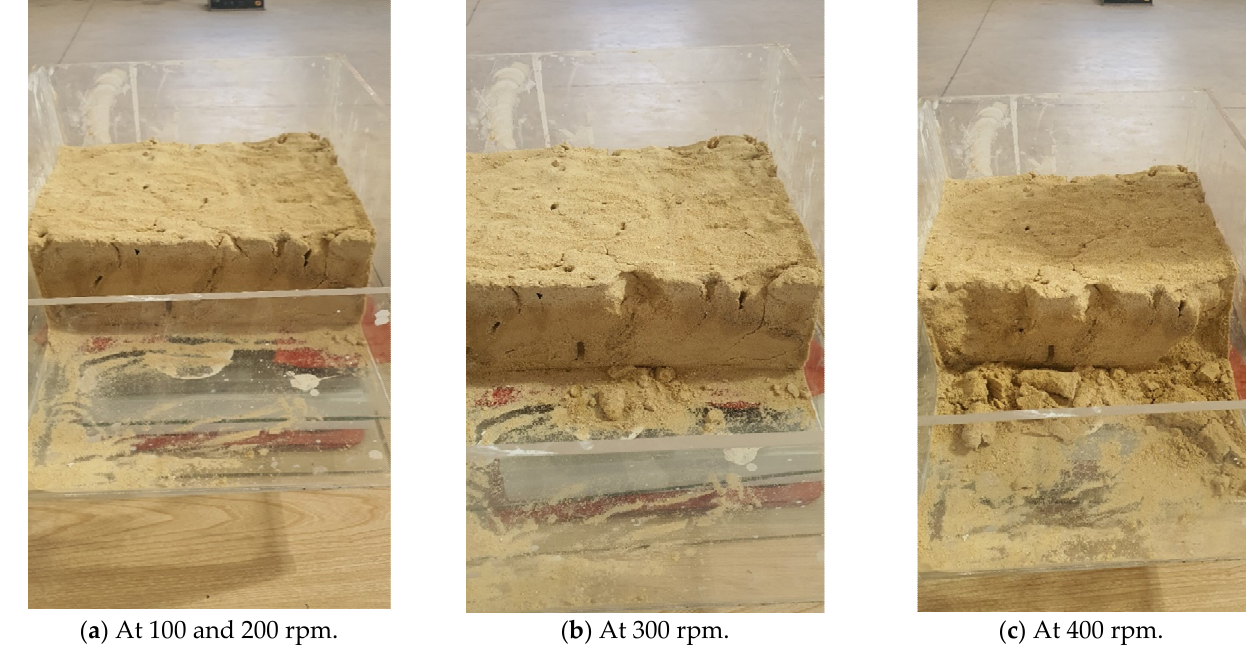
Figure 12. Shaking the stabilized Sweileh sand with 4% bentonite clay at 100 to 400 rpm for 10 min each time.